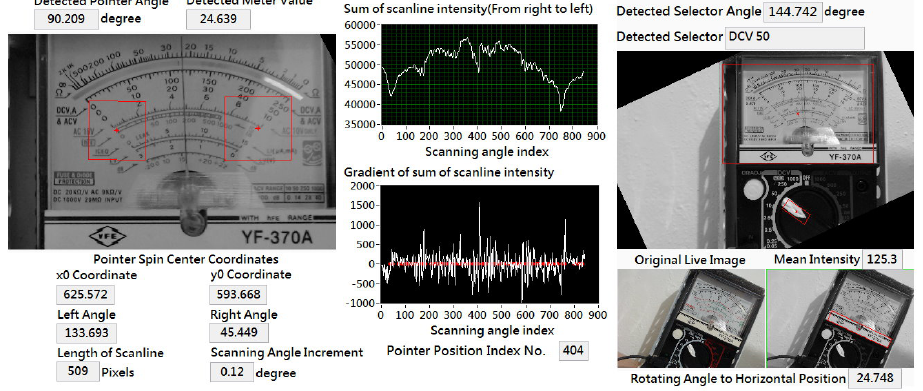
Figure 17. An illustrative result directly displayed on the LabVIEW environment for scenario (2), “A-meter rotated right” (24.639 ◦ ), presented in Section